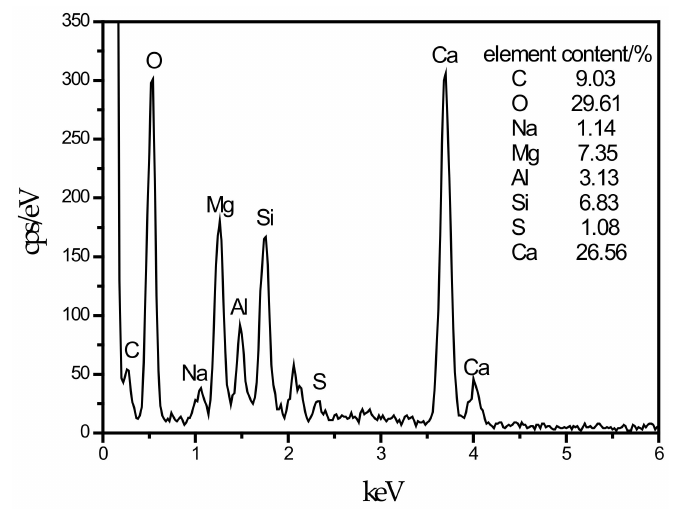
Figure 8. EDS energy spectrum of LDHs cover